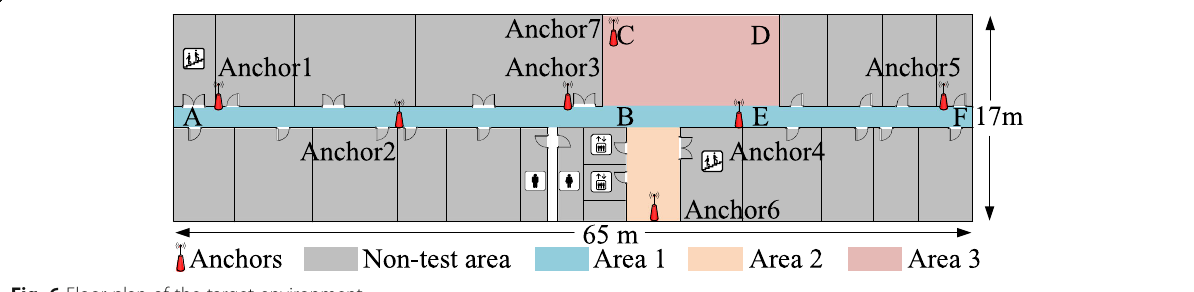
Fig. 6 Floor plan of the target